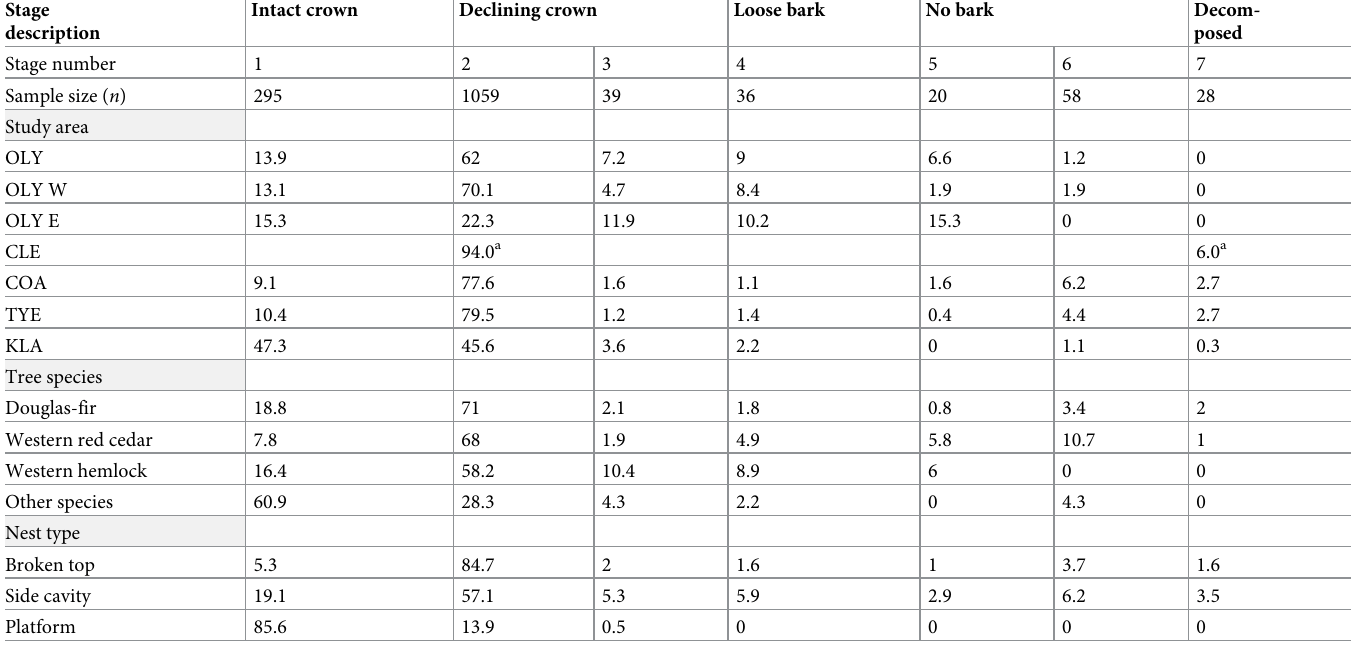
Table 3. Percentages of decomposition stages of nest trees of northern spotted owls in Washington and Oregon, USA, subdivided by study area, species, and nest